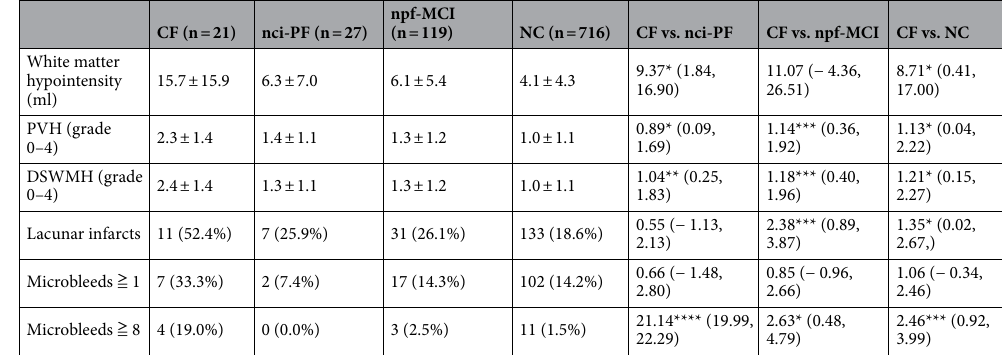
Table 4. Small-vessel disease MRI features of each clinical group and pair-wise comparisons with the cognitive frailty group. Data are presented as the mean ± standard deviation, or number and proportion (percentage). For group comparisons, regression beta coefficients are presented with a 95% confidence interval. CF cognitive frailty, nci-PF non-cognitive-impaired physical frailty, npf-MCI non-physically-frail mild cognitive impairment, NC normal control, PVH periventricular hyperintensity, DSWMH deep and subcortical white matter hyperintensity. *p < 0.05, **p < 0.01, ***p < 0.005, ****p < 0.001.